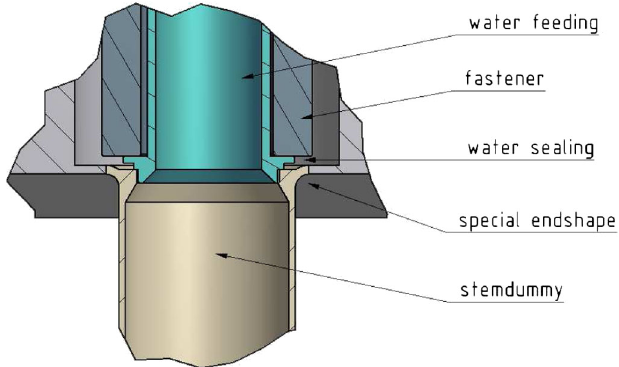
45. Schematic view of the connection between the stem and the outer cylinder.